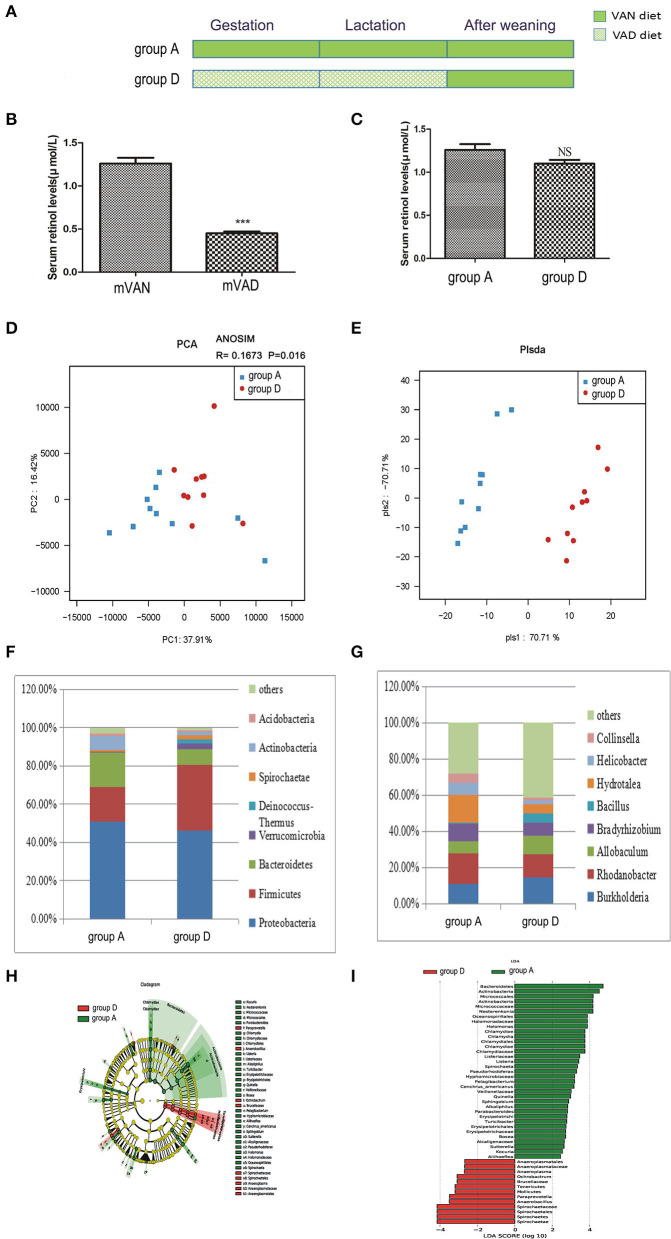
The comparison of colonic mucosal microbiota between the group A and group D. (A) Schematic diagram showing the two offspring groups: group A, group D. The group A pups were delivered and nursed by maternal VAN rats and then fed a VAN diet for 3 wk after weaning. The group D pups were birthed and nursed by maternal VAD rats and fed a VAN diet for 3 wk after weaning. (B) The serum retinal levels of maternal rats. Serum VA levels were detected by HPLC. Values represent mean ± SD n = 10 mVAN and 10 mVAD, ***P < 0.001 by Student's t-test. (C) The serum retinal levels of offspring at 6 weeks old. Serum VA levels were detected by HPLC. Values represent mean ± SD n = 10 group A and 10 group D, p = NS (not significant) by Student's t-test. (D,E) The PCA and PLS-DA analysis of the samples between the group A and group D. (D) PCA scores were plotted based on the relative abundance of OTUs (n = 10). (E) PLS-DA was plotted based on the unweighted UniFrac distance metrics (n = 10). The red circles represent for the group D, blue squares for the group A. (F) The phylum level of dominant bacteria with relative abundance more than 1% in the two groups. (G) The genus level of dominant bacteria with relative abundance more than 5% in the two groups. (H,I) Different structures of colonic mucosal microbiota in rats with VAN or VAD diet by LEfSe analysis. (H) A cladogram of the statistical and biological differences in the colonic microbiota between the group A and group D, which are shown by the color of the most abundant phylotypes (red indicating group D green group A, and yellow non-significant) (n = 10). (I) A histogram of the LDA scores for the most abundant phylotypes (n = 10).